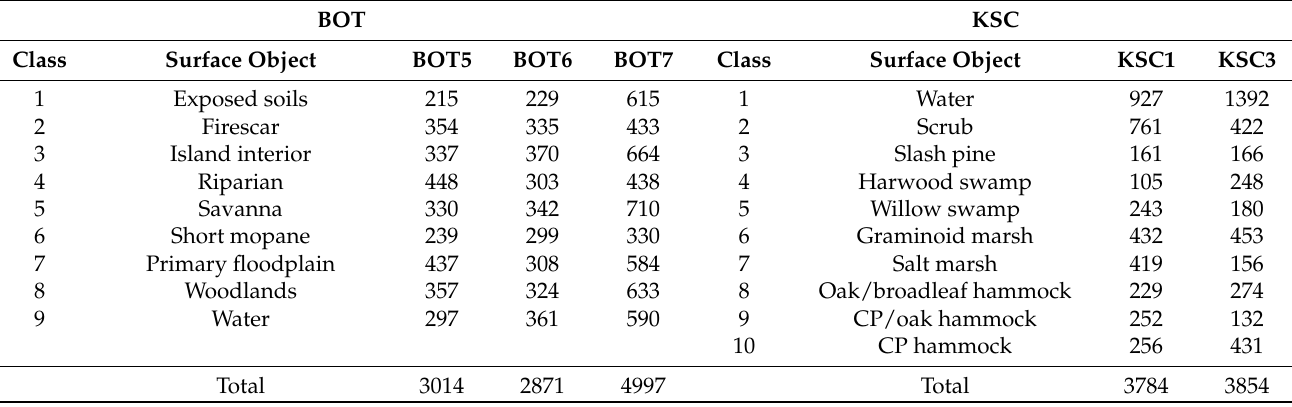
Table 1. Class names and number of samples of BOT and KSC